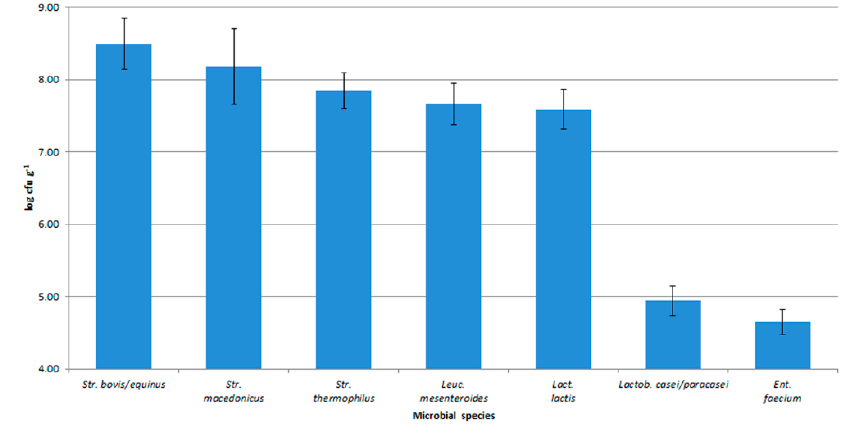
Figure 3. Distribution of endogenous species in Caciotta Leccese after 60 days of ripening.